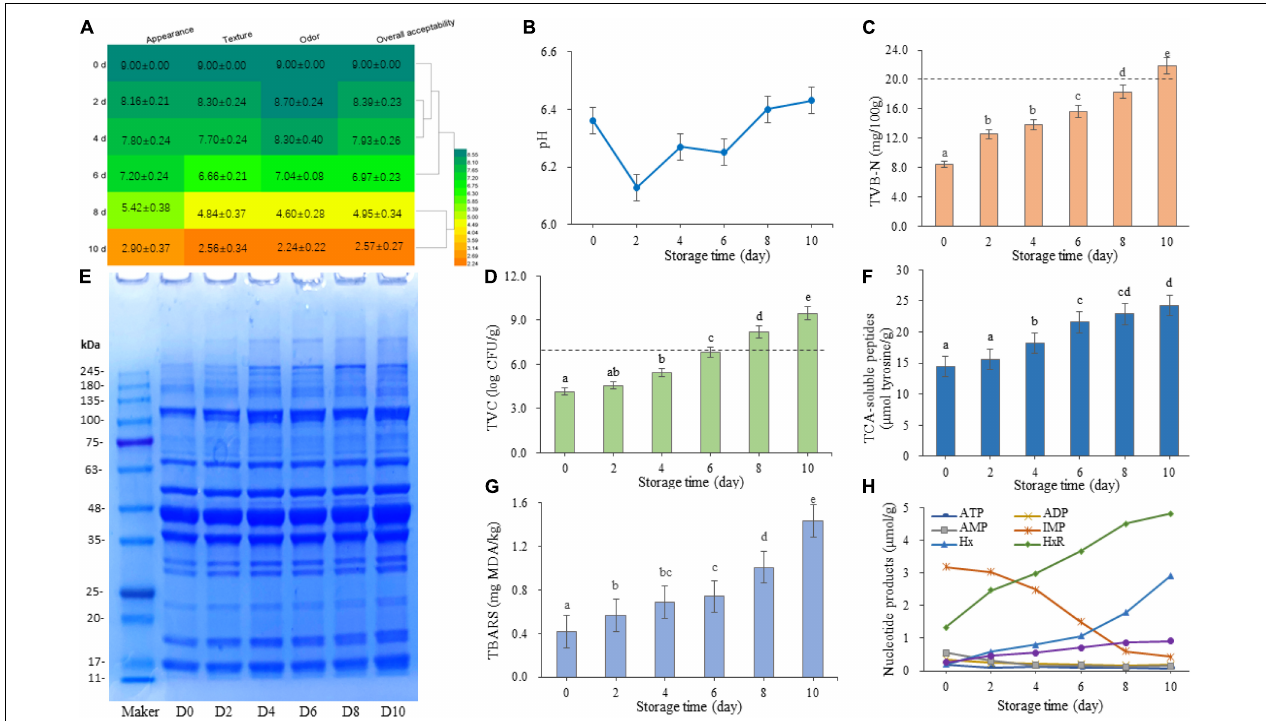
FIGURE 1 | Changes in sensory index (A) , pH value (B) , total volatile basic nitrogen (C) , total viable counts (D) , protein degradation (E) , trichloroacetic acid-soluble peptides (F) , thiobarbituric acid reactive substances (G) , and nucleotide degradation products content and K -value (H) of sturgeon filets during storage at 4 ◦ C. The sensory scores were processed using Heml 1.0.3.7. Different lowercase letters indicate significant differences ( P < 0.05) in the